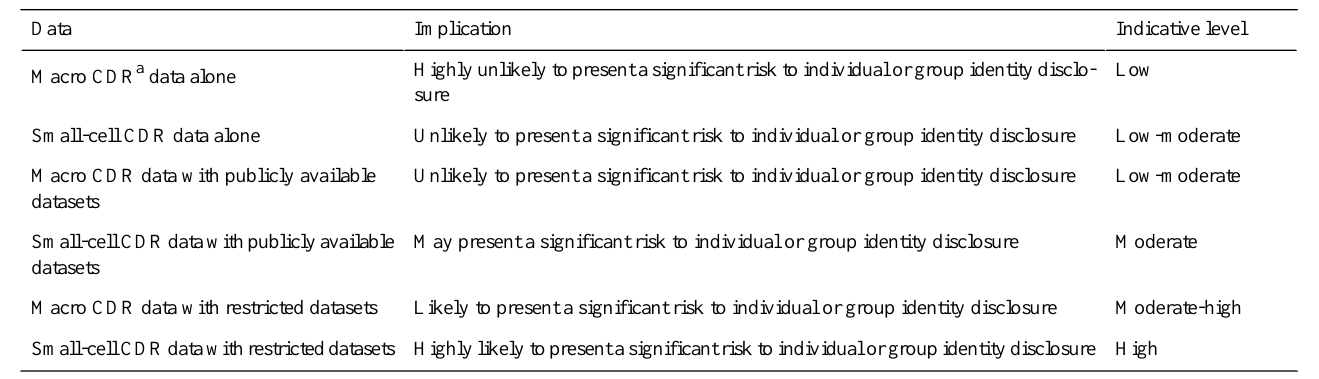
Table 1. Indicative relative disclosure risk